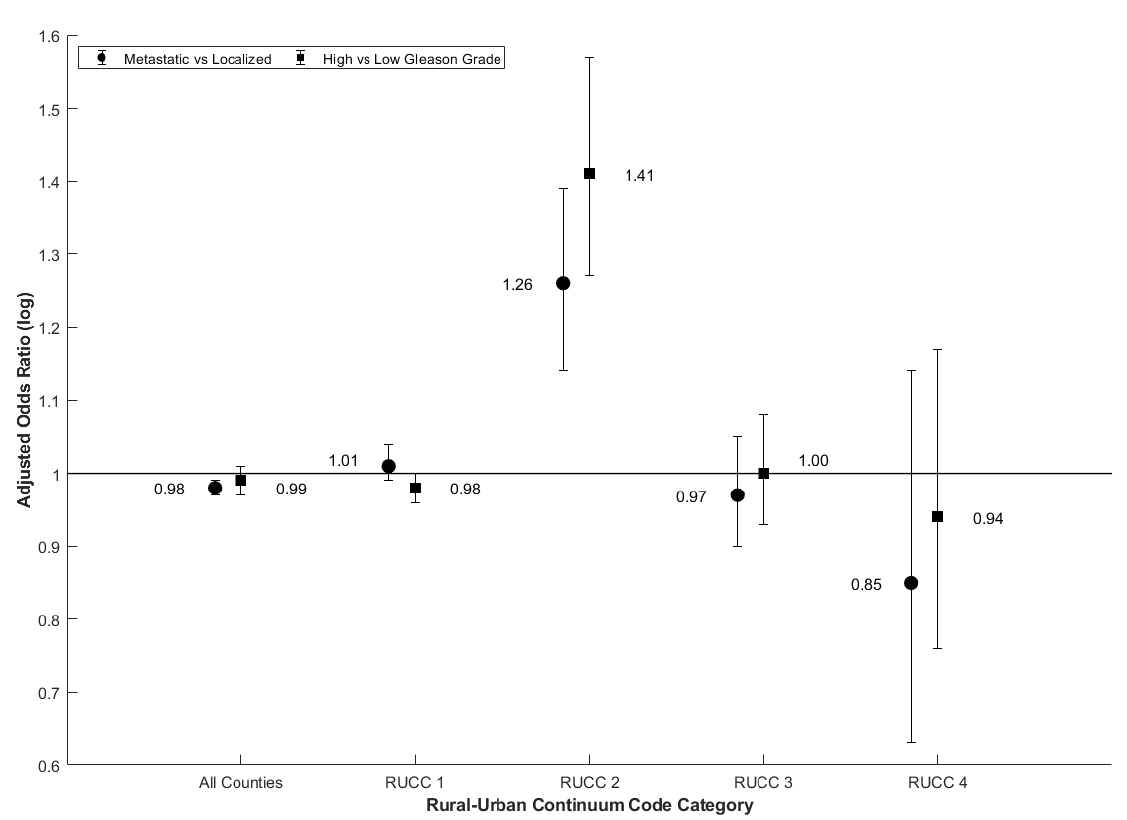
Figure 2. Adjusted odds ratios for metastatic vs. localized and high vs. low Gleason grade prostate cancer for the 80th vs. 20th percentile of cadmium exposure concentration (OR, 95% CI) from Surveillance Epidemiology, and End Results (SEER), a nationally representative cohort in the US. Note: Adjusted odds ratios were adjusted for age at diagnosis, county-level sociodemographic index, county-level smoking prevalence, and county-level air quality index.